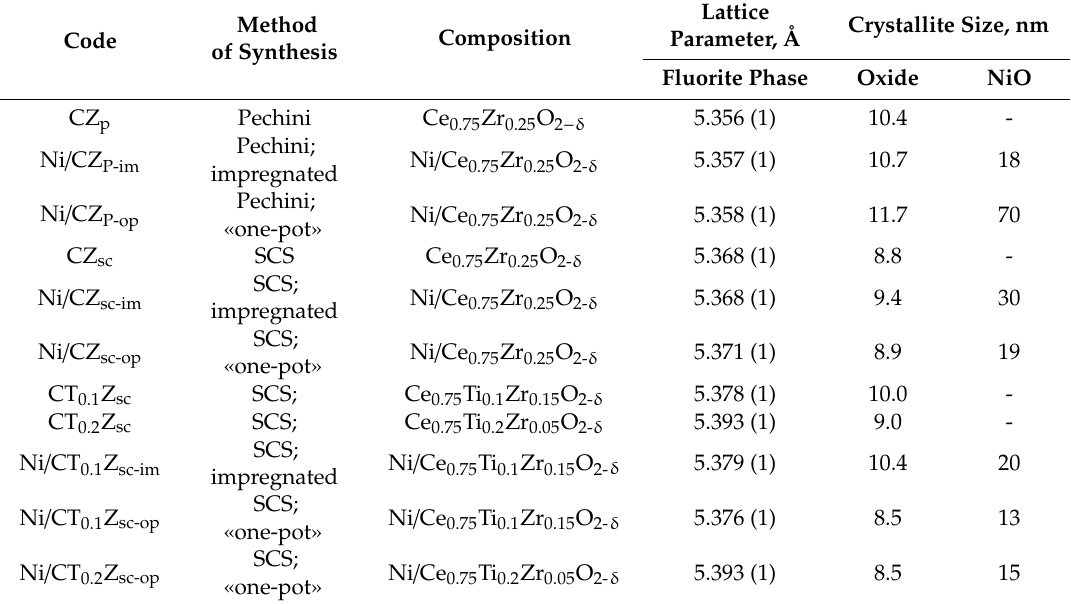
Table 1. Structural properties of as prepared supports and 5% Ni / Ce(Ti)ZrO 2 catalysts according to